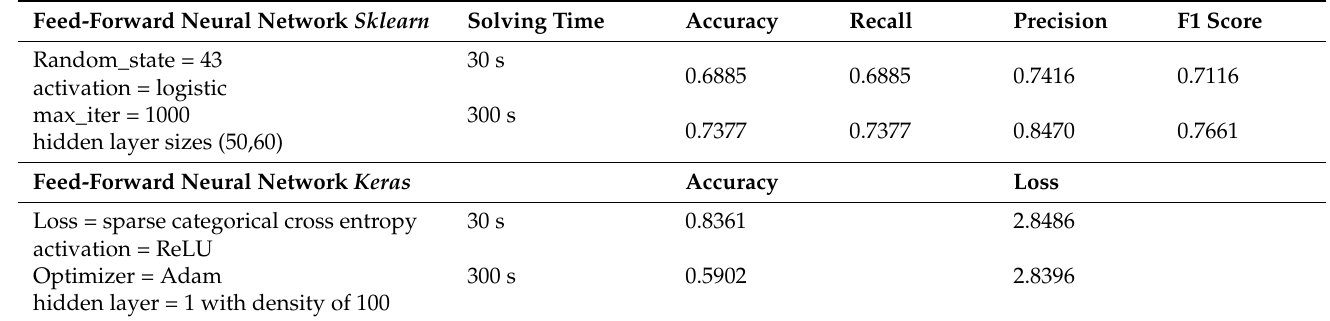
Table 7. Performance metrics of the neural network for JSSP datasets.